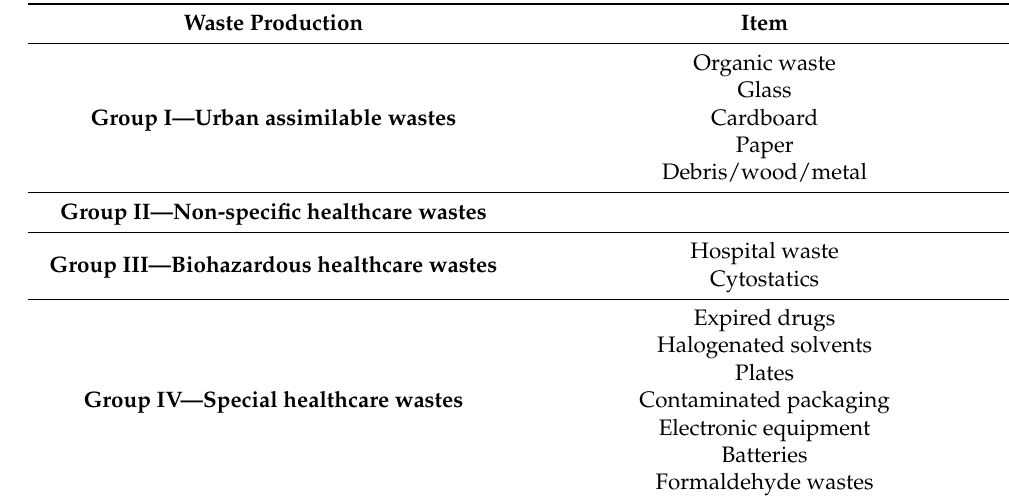
Table 2. Details of the elements included in the different waste groups produced by the hospital in